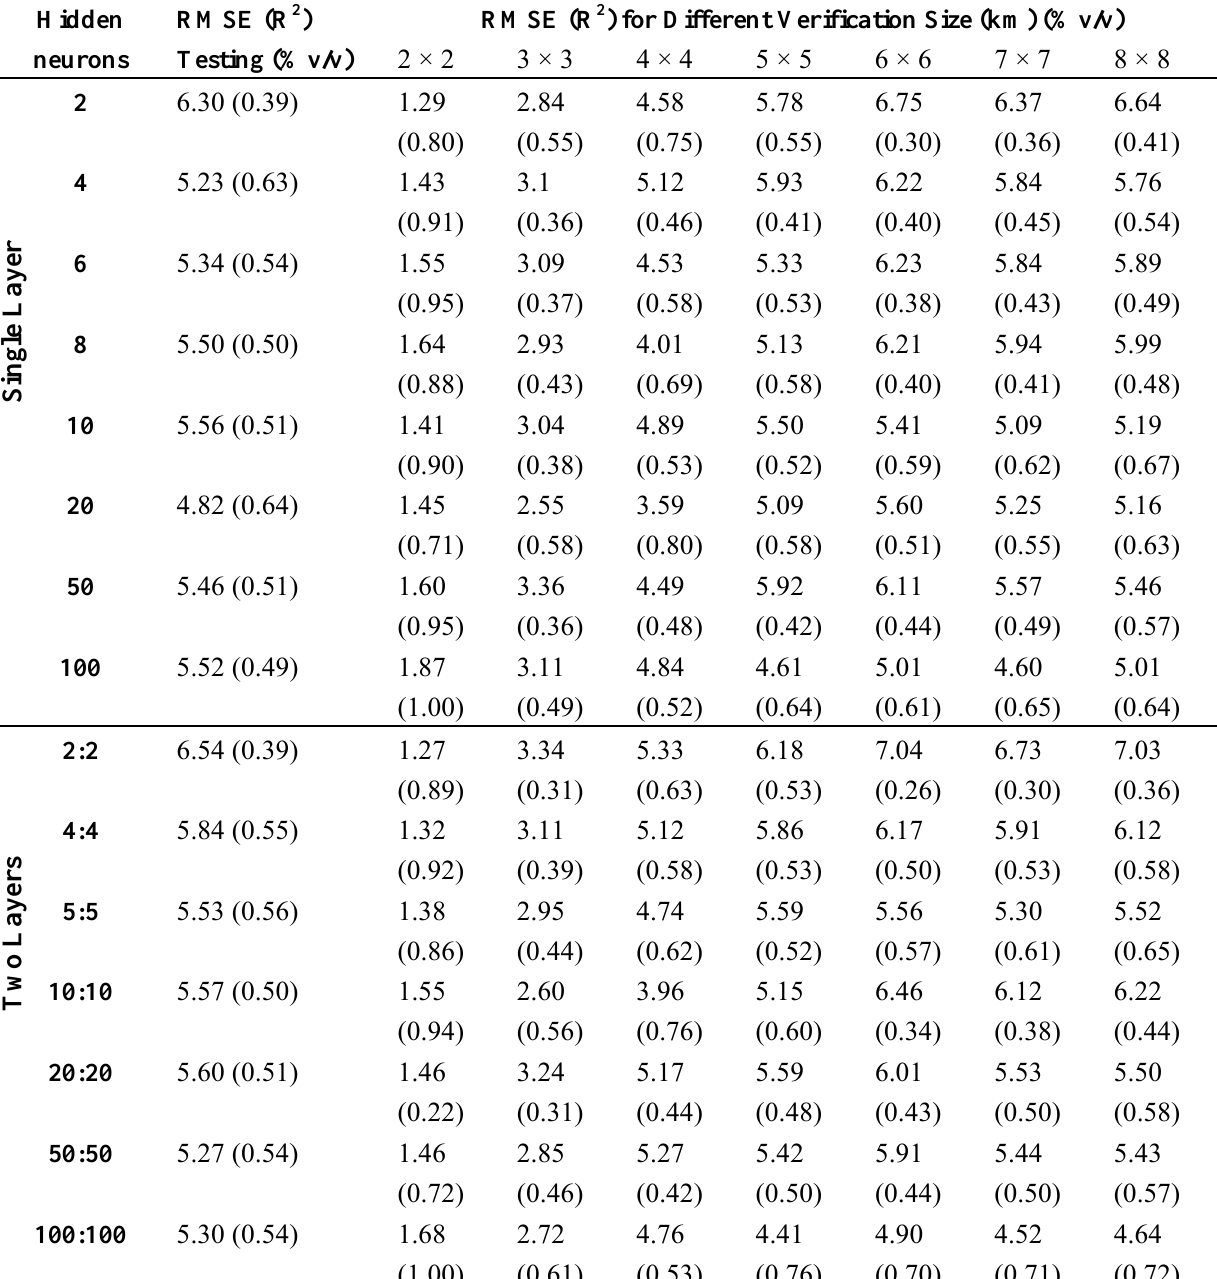
Table 4. As for Table 3 but using TbH, TbV and NDVI as